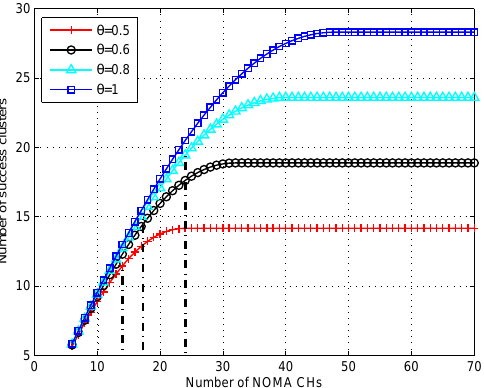
Figure 2. Comparison of the number of success clusters against the number of non-orthogonal multiple access (NOMA) cluster heads (CHs) when θ = 0.5, 0.6, 0.8,